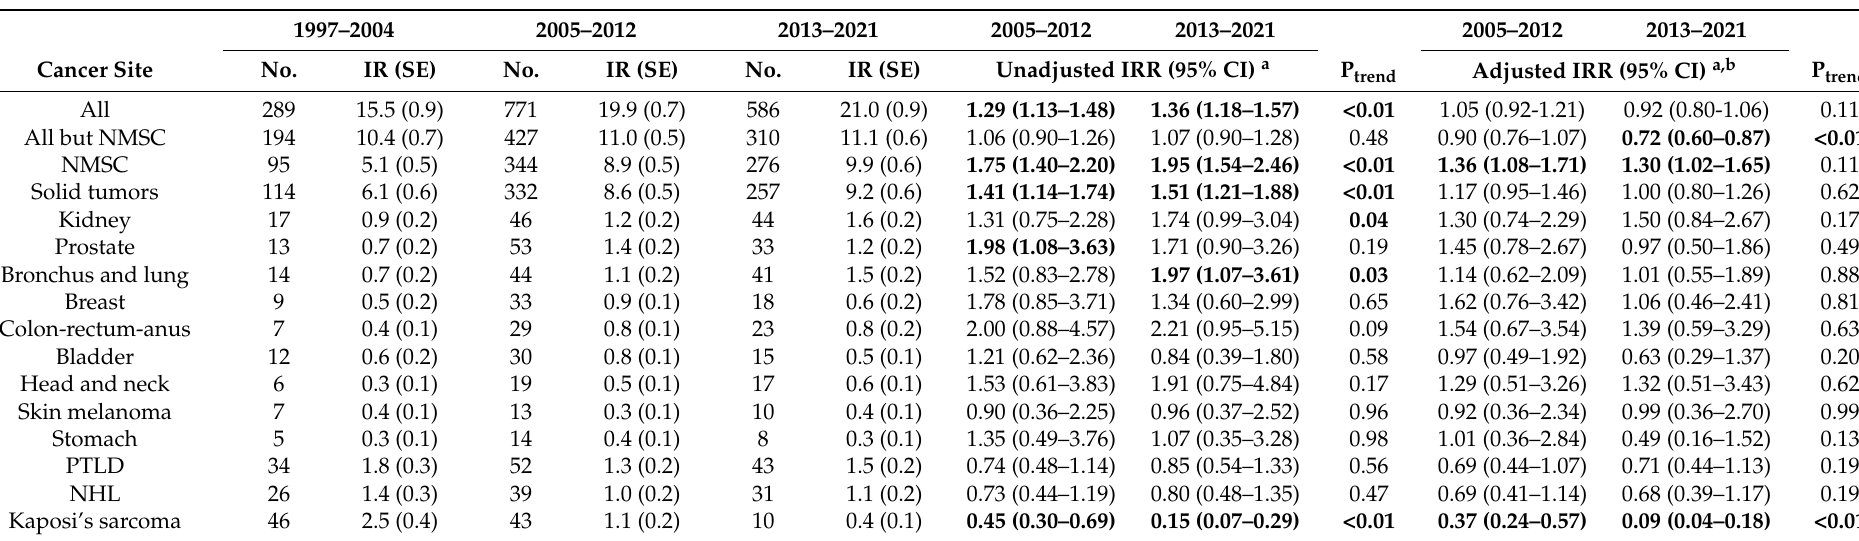
Table 2. Incidence rates (IR) per 1000 person-years and incidence rate ratios (IRR) for major cancer sites, by calendar period of cancer